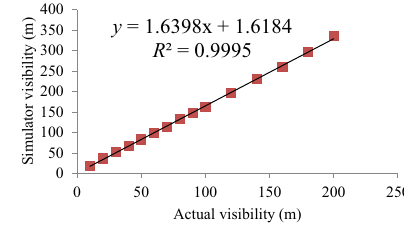
Figure 3 The fi tting result of actual scene visibility and simulator visibility